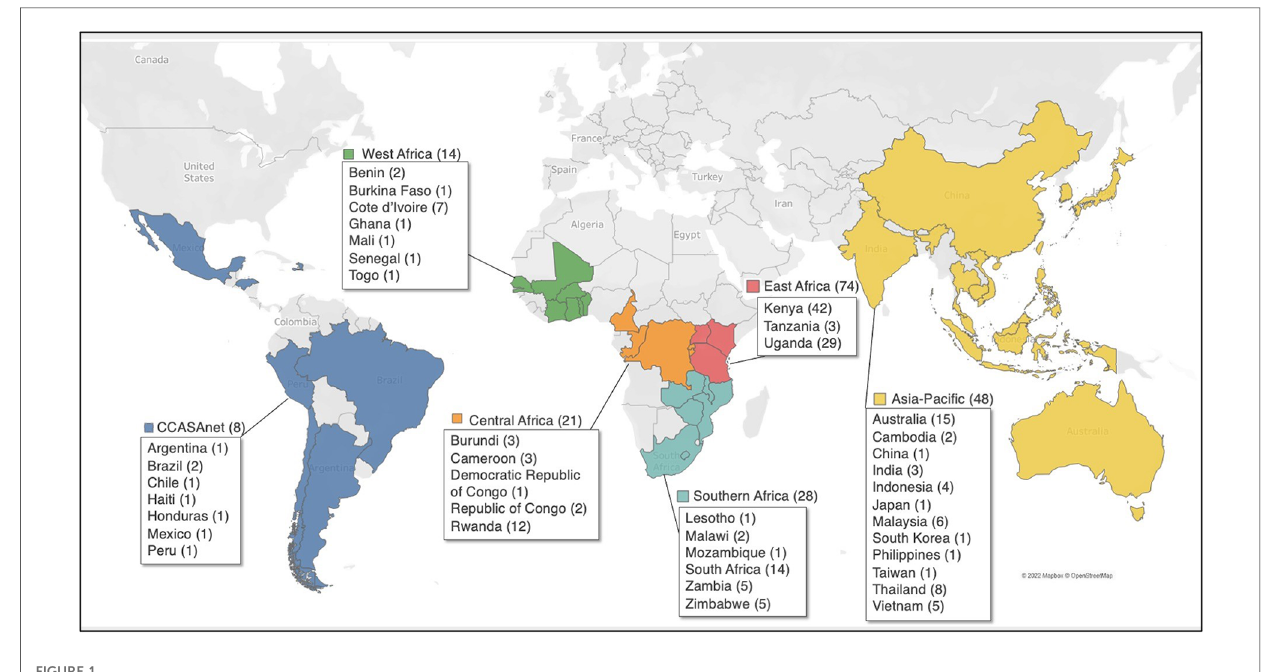
FIGURE 1 IeDEA sites included in the